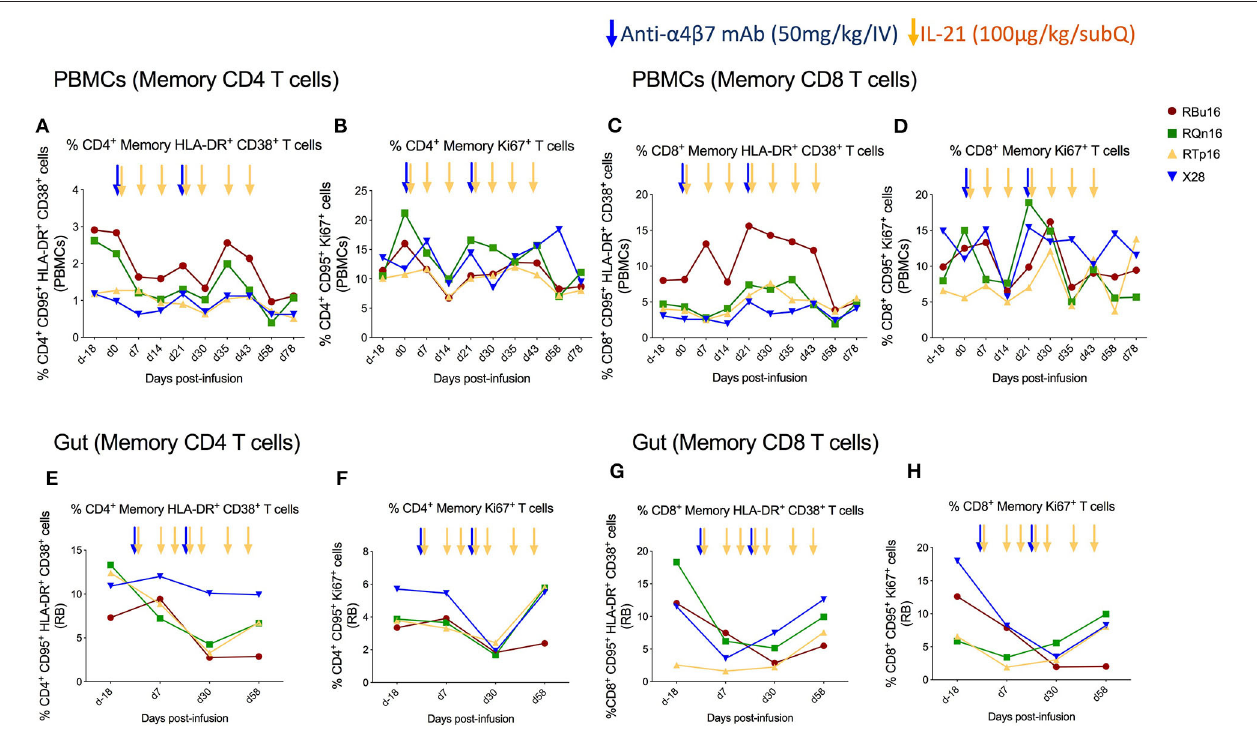
FIGURE 4 | Co-administration of anti- α 4 β 7 mAb and IL-21 limits immune activation and cell cycling of memory CD4T cells in gut . (A) Percentage of memory CD4T cells expressing HLA-DR + CD38 + , (B) Ki67 + , (C) memory CD8T cells expressing HLA-DR + CD38 + , and (D) Ki67 + in PBMCs. (E) Percentage of memory CD4T cells expressing HLA-DR + CD38 + , (F) Ki67 + , (G) memory CD8T cells expressing HLA-DR + CD38 + , and (H) Ki67 + in gut mucosa. Individual animals are represented with different colors and symbols. Baseline days are indicated as d-18 and d0. Blue arrows indicate the anti- α 4 β 7 mAb intravenous infusions, and yellow arrows indicate IL-21 subcutaneous